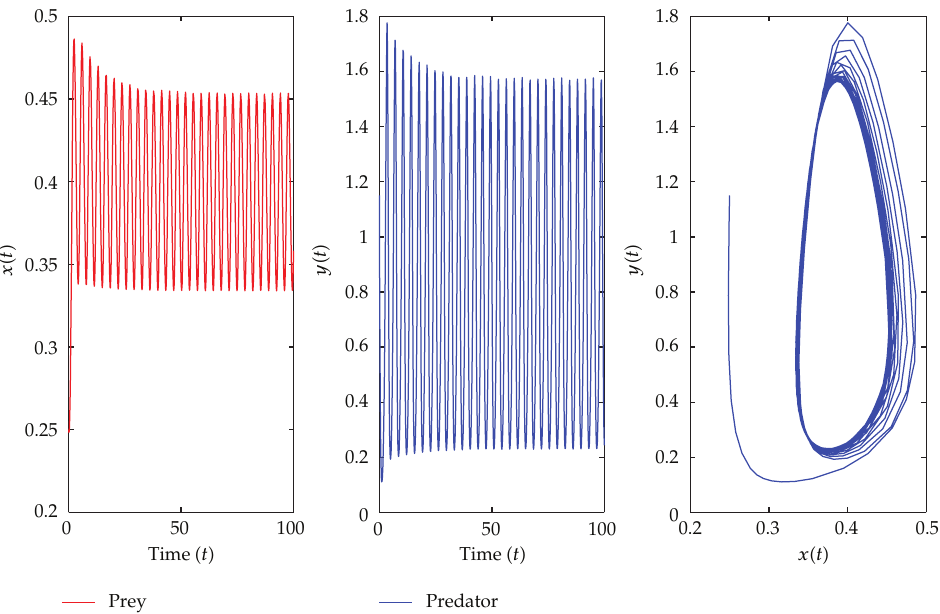
Figure 6: E (cid:7) 0 . 3333 , 0 . 6666 (cid:8) is unstable when τ (cid:6) 0 . 74 > τ 0 (cid:6) 0 . 7015 with initial value 0.25,